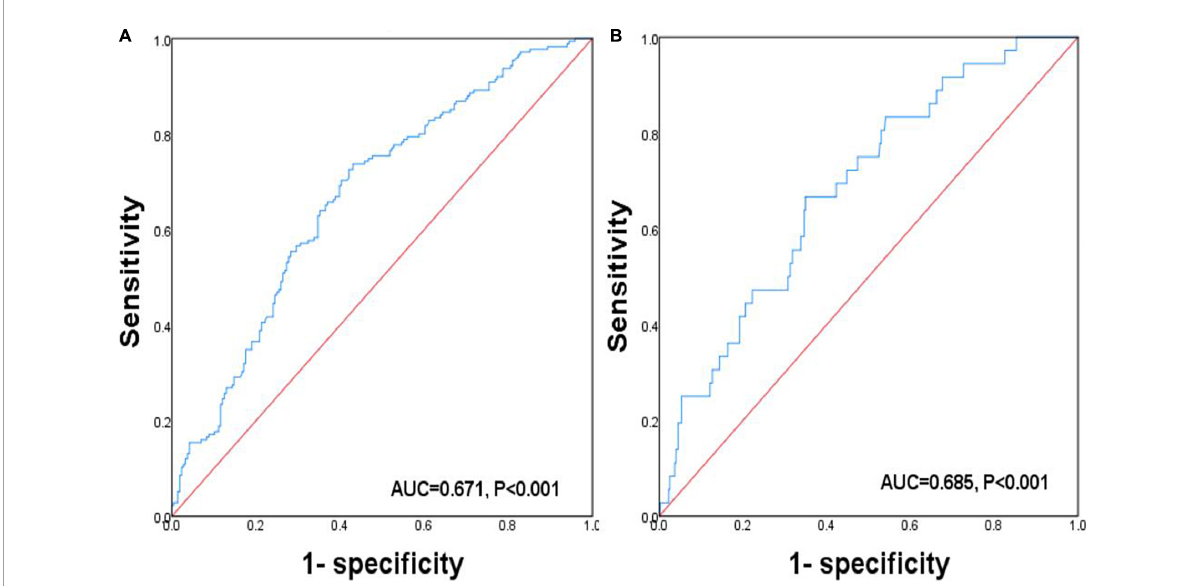
FIGURE2 Receiver operating characteristic curve analysis related to the impact of Cre/CysC on the BMDs. (A) ROC curve analysis related to the impact of Cre/CysC on the diagnosis of osteopenia. (B) ROC curve analysis related to the impact of Cre/CysC on the diagnosis of osteoporosis.